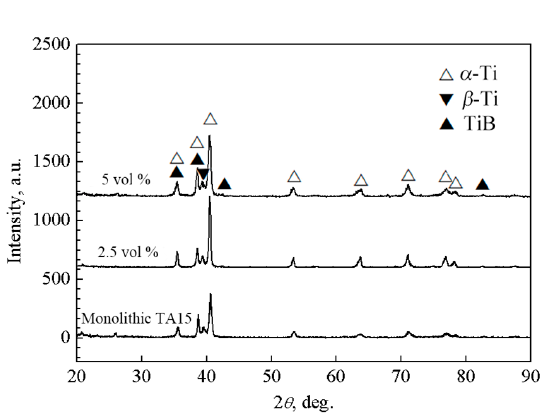
Figure 3. X-ray diffraction patterns of monolithic TA15 alloy and TiBw/TA15 composites with different volume fractions of reinforcement.